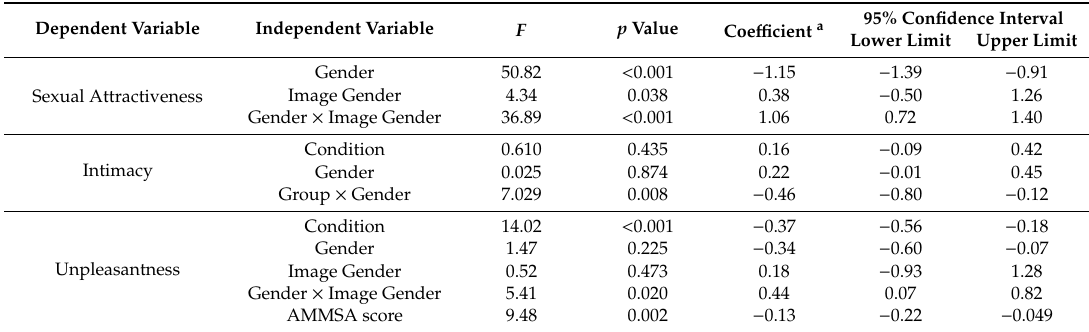
Table 2. Final models of the influences on ratings of sexual attractiveness, intimacy, and presumed unpleasantness of further distribution.